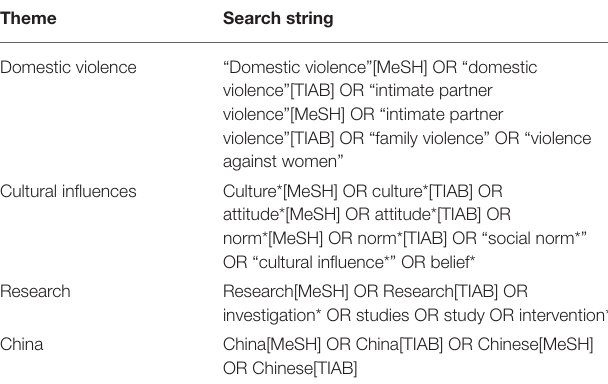
TABLE 2 | List of articles